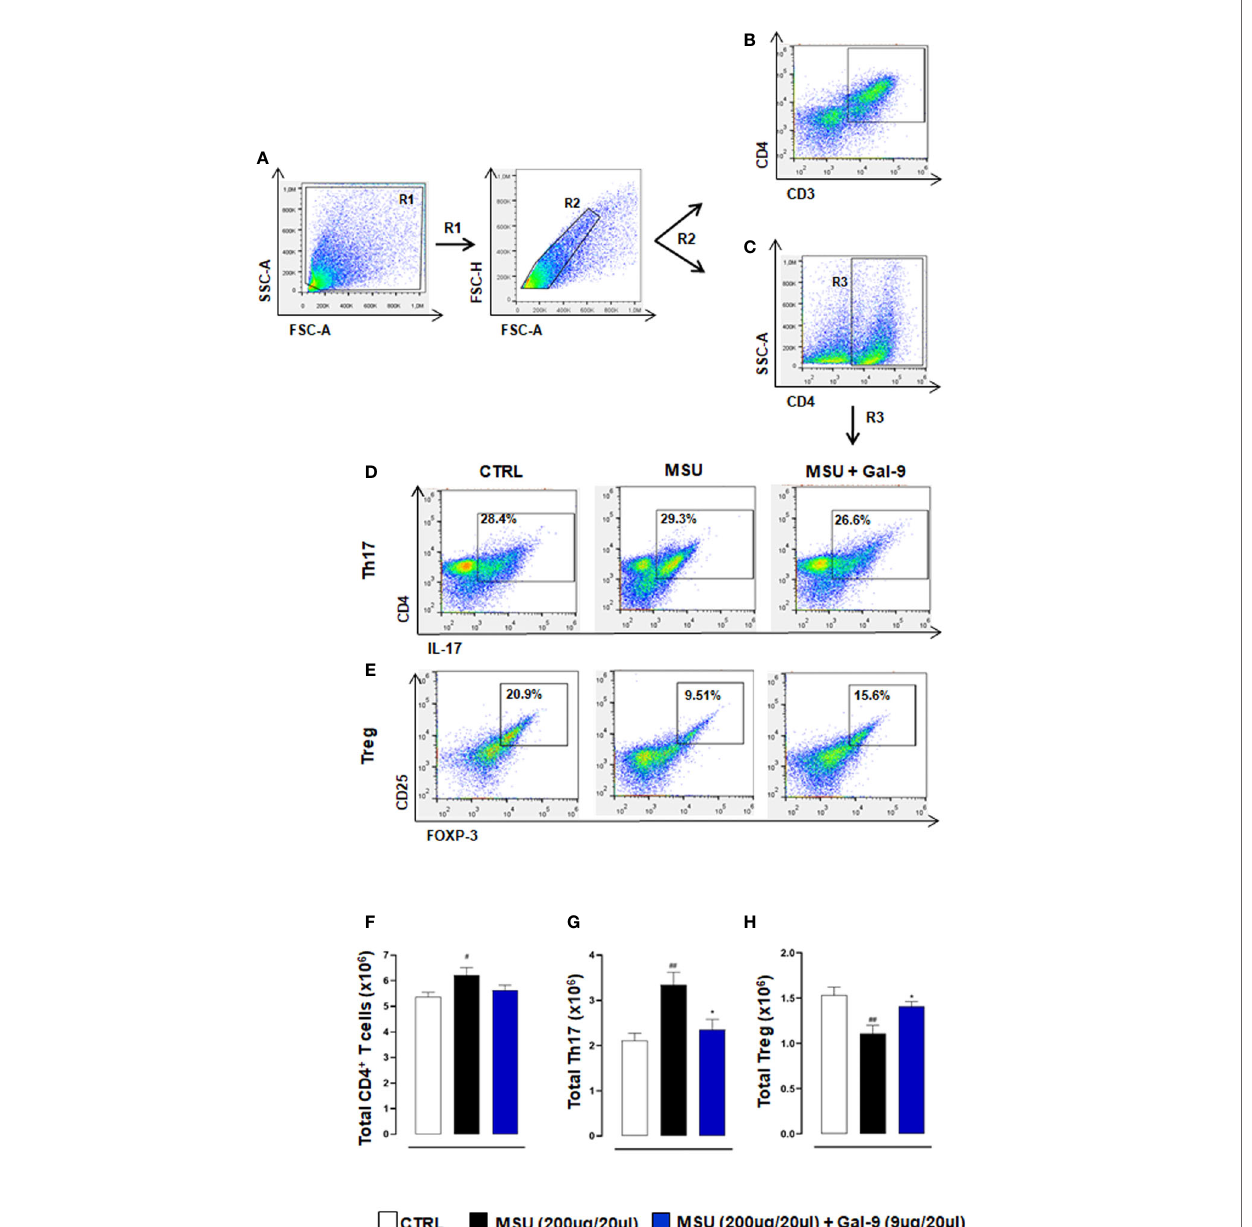
FIGURE 3 | Gal-9 sustains local Treg levels. Flow cytometry analysis was employed to determine in situ levels of CD4 + T cells, Th17 and Tregs subsets. At the peak of the in fl ammatory reaction (18h), ankle joints were digested, and single cell suspensions were obtained. Flow cytometry strategy applied to identify the modulation of CD3/CD4 (A, B) , CD4 + T cells (A, C) , Th17 (A, C, D) and Tregs (A, C, E) after Gal-9 treatment are shown. Cells were washed and stained with: CD3, CD4, CD25, and intracellular antibodies IL-17A and FOXP-3. Th17 and Treg populations were de fi ned as CD4 + /IL-17 + (A, C, D) and CD4 + /CD25 + /FOXP-3 + (A, C, E) respectively. (F) Total CD4 + T cells, (G) Th17 and (H) Tregs were quanti fi ed in the different experimental conditions. Representative FACS plots of three independent experiments with similar results are shown. Values are presented as means ± SEM of n = 6 mice per group. Statistical analysis was conducted by one-way ANOVA followed by Bonferroni ’ s test for multiple comparisons. # P ≤ 0.05, ## P ≤ 0.01 vs Ctrl group; *P ≤ 0.05 vs MSU